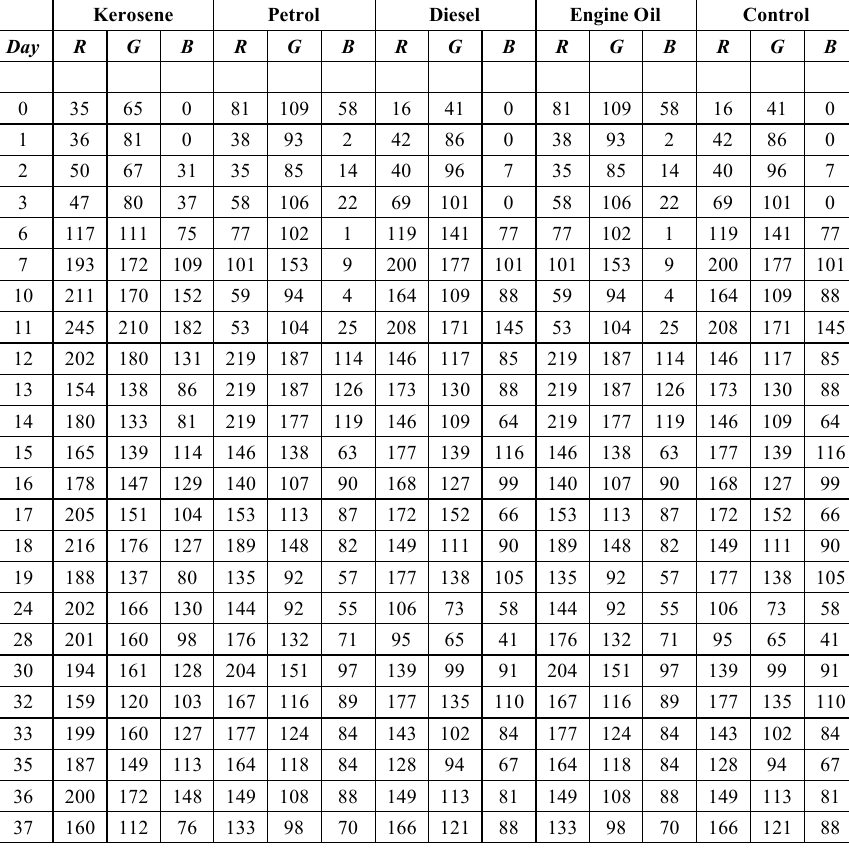
Table 1. RGB Colour Values per Oil Type (Kerosene, Petrol,